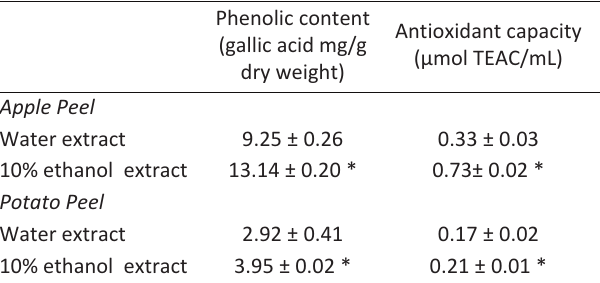
Data are reported as mean ± SE (n= 3). In the columns, and within species, asterisks indicate significant differences between solvents according to Student t